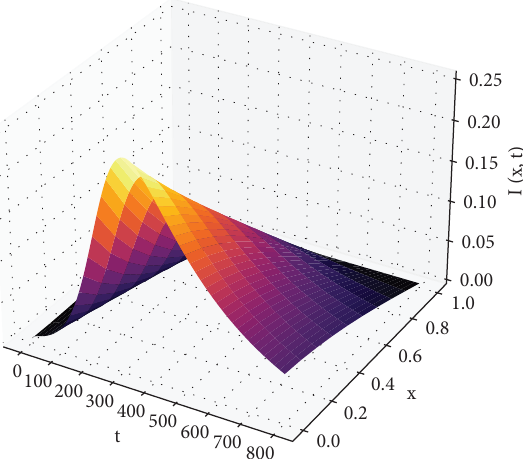
Figure 4: A 3-dimensional plot for the proportion of infective in space and time.